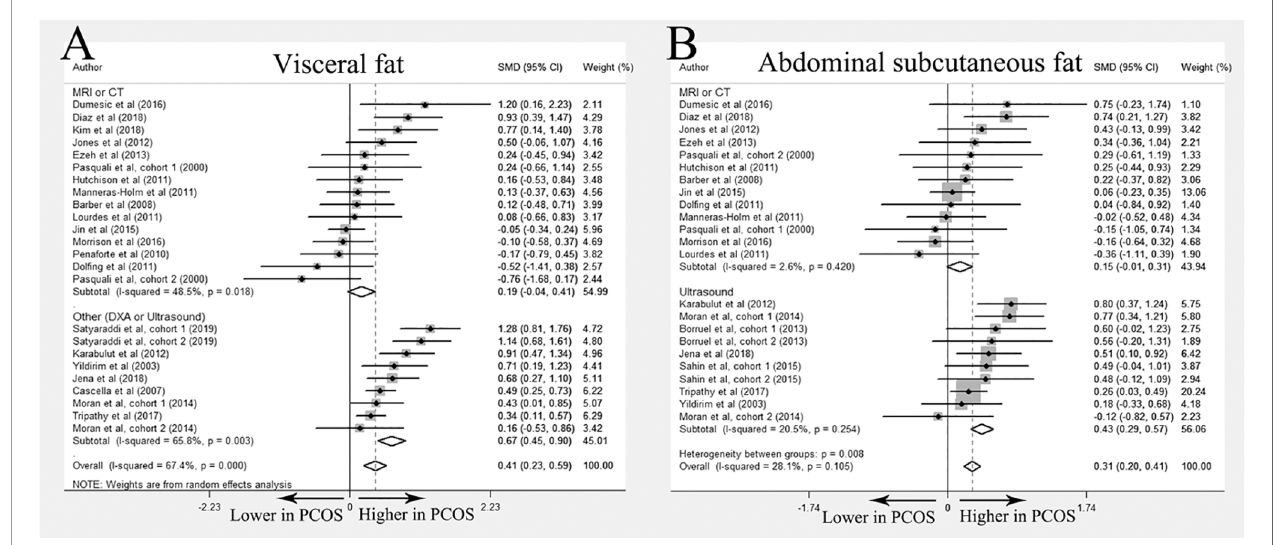
FIGURE 2 | Meta-analysis on visceral fat and abdominal subcutaneous fat: women with PCOS versus BMI-matched healthy controls. Forest plot displayed odds of visceral fat (A) and abdominal subcutaneous fat (B) in